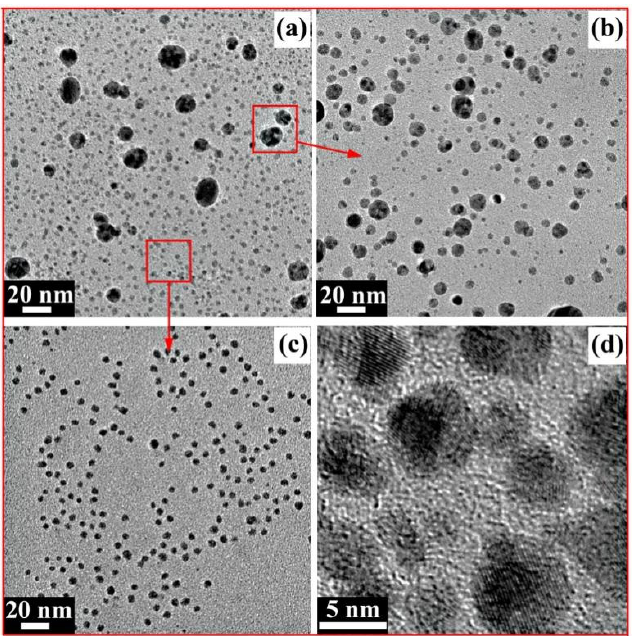
Figure 7. ( a ) TEM image of AgNPs; ( b ) TEM image of redispersed AgNPs in sediment; ( c ) TEM image of AgNPs in supernatant; ( d ) HRTEM image of AgNPs in supernatant.